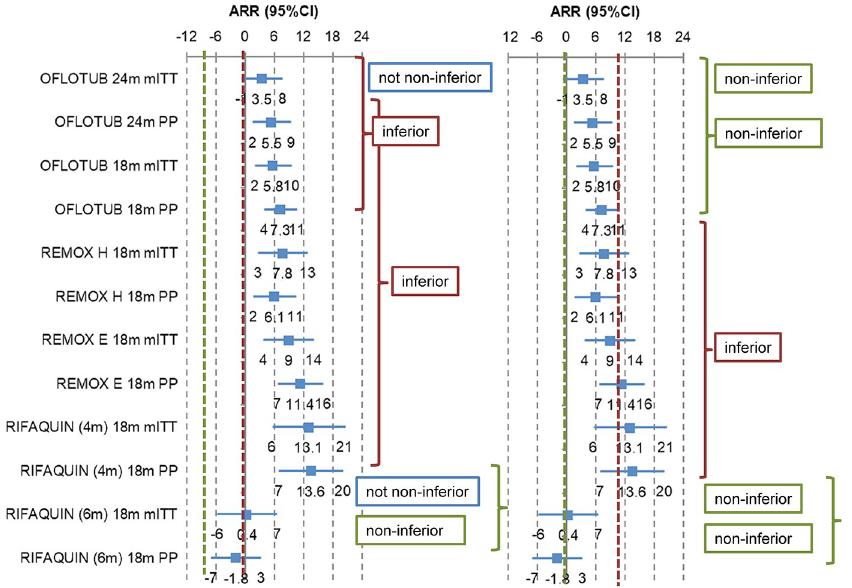
Fig 2. Unfavourable treatment outcome with fluoroquinolone-substitution regimens versus standard regimen for DSTB expressed as ARR with 95% CIs interpreted against a 6% (predetermined) and a 10% (post hoc) noninferiority margin. 18m, 18 month follow-up from treatment start; 24m, 24 month follow-up after treatment end; ARR, absolute risk reduction; CI, confidence interval; DSTB, drug-sensitive tuberculosis; mITT, modified intent-to- treat set; PP, per-protocol